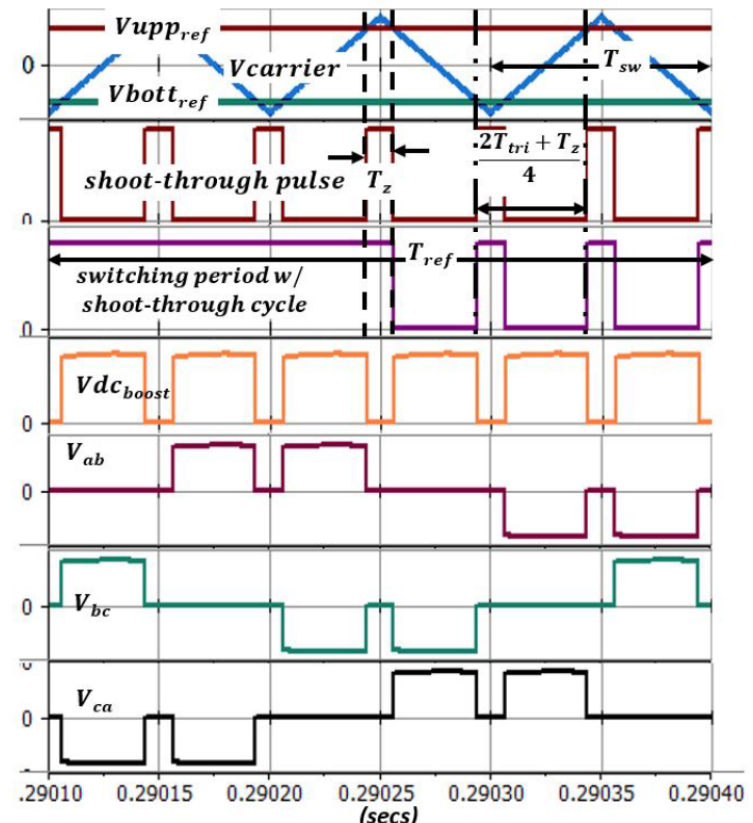
Figure A1. Switching PWM sequences for ZSI